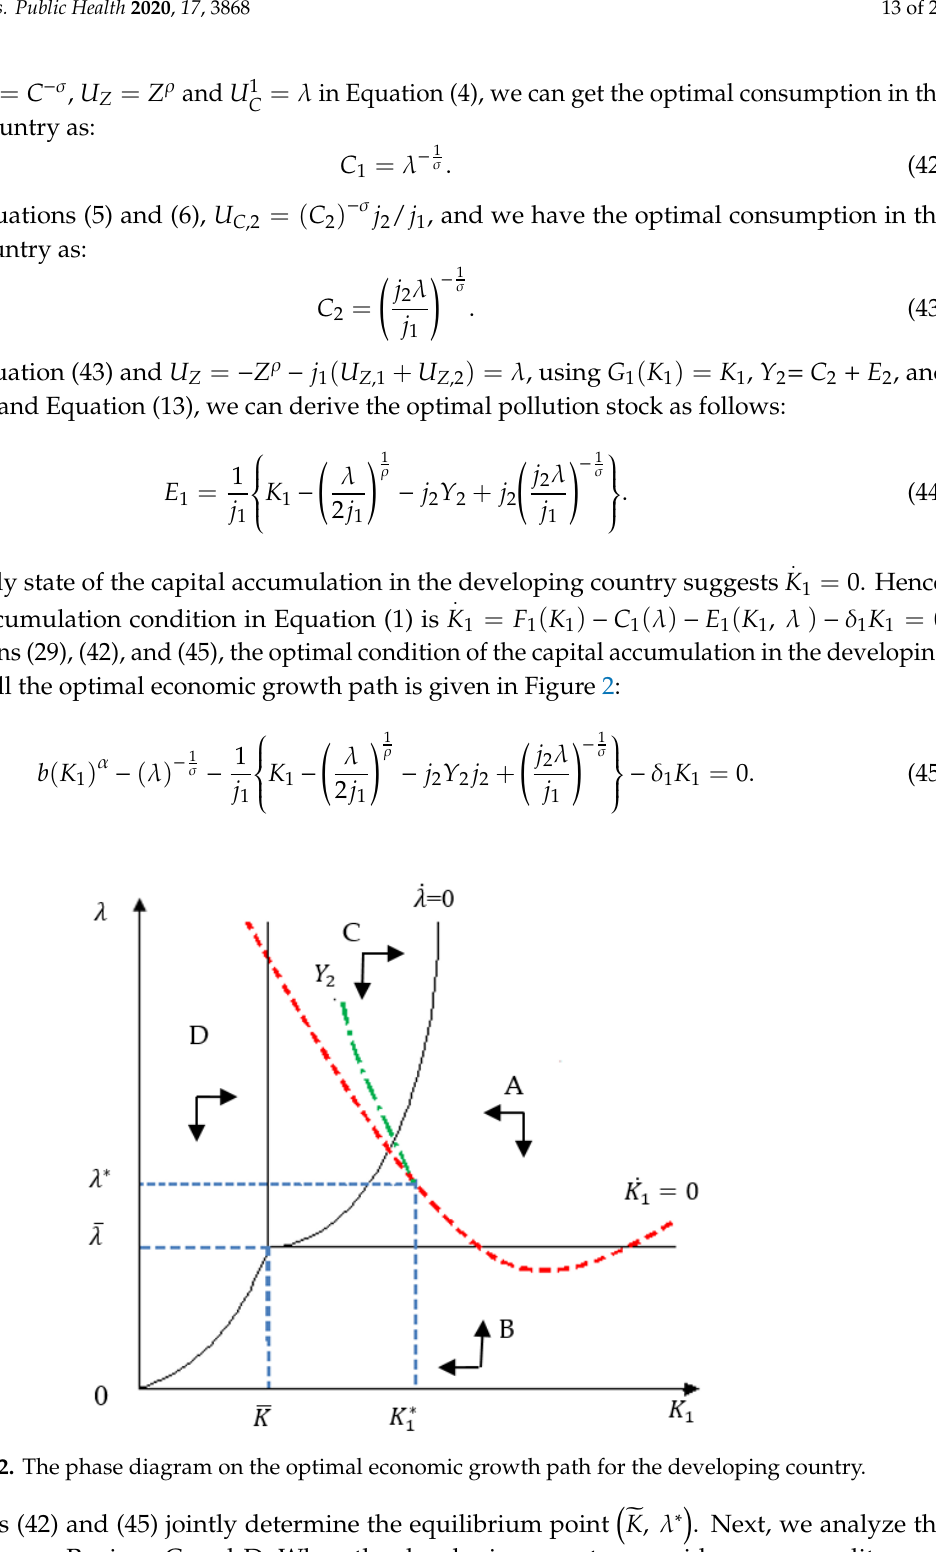
1 𝜌 , 𝜆̅ = 𝑈 𝐶,2 𝑗 1 𝑗 2 ⁄ .